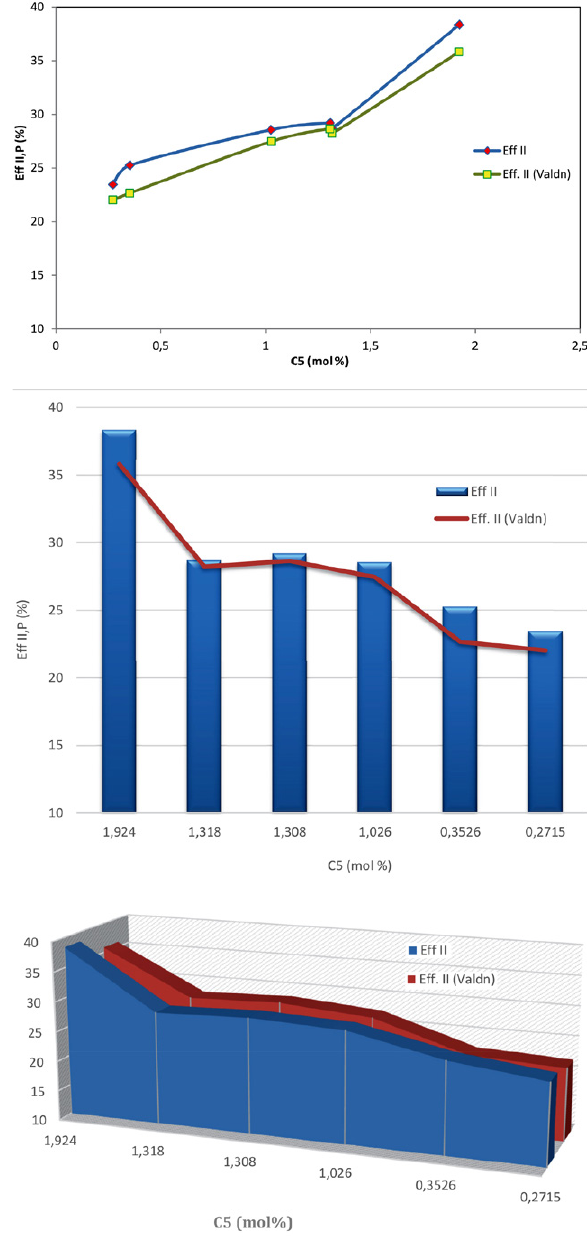
Fig. 6. Effect of Pentane Concentration Variation on Exergetic Effi- ciency